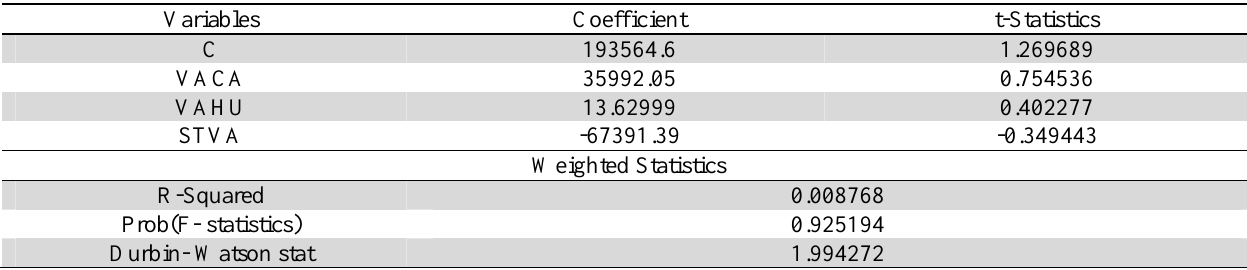
Cross- section random effects of Hypothesis